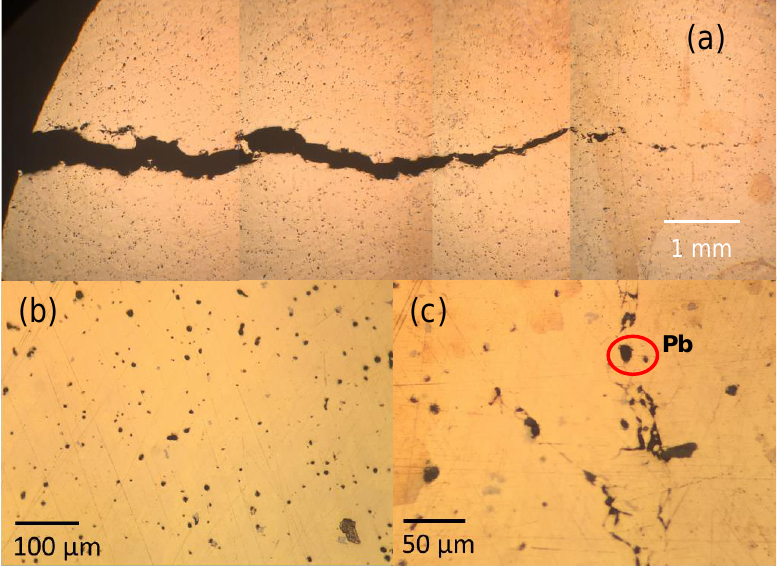
Figure 4. Optical micrographs of the cross-section morphology. ( a ) crack propagation, ( b ) black Pb particles, ( c ) small cracks along the Pb particles.